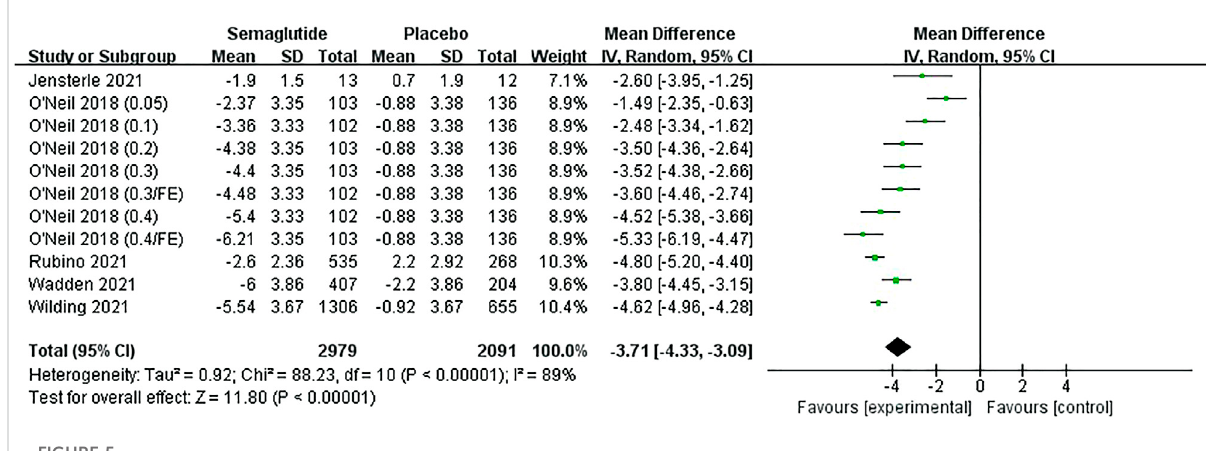
FIGURE 5 Meta-analysis results of BMI change (kg/m 2 ) in included